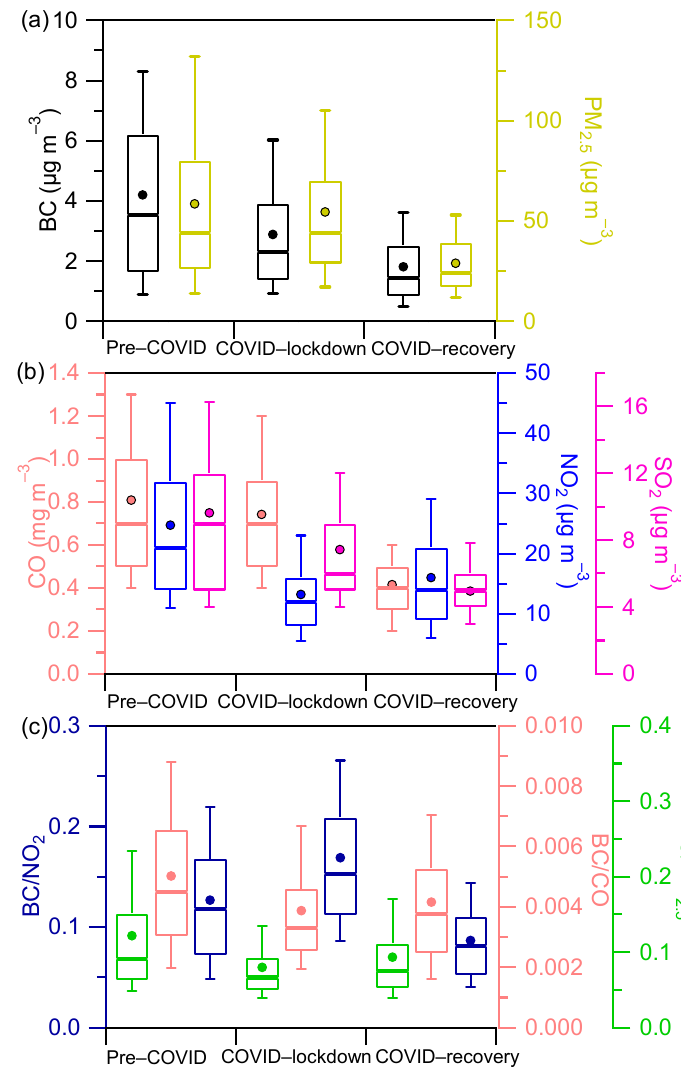
Figure 10. Mass concentration of BC and PM 2.5 ( a ); mass loading of CO, NO 2 , and SO 2 ( b ); the ratio of BC to NO 2 , BC to CO, and BC to PM 2.5 ( c ) in different stages about the COVID-19 pandemic, respectively.